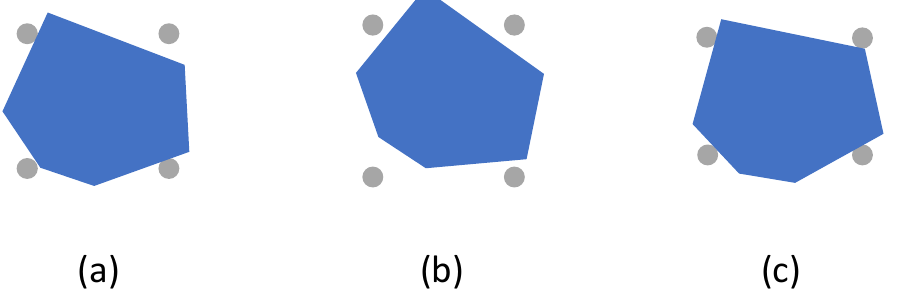
Figure 5. Example of rewards from the GQS function for different cases. ( a ) Some of the pins are on the surface of the object. Reward: − 0.017. ( b ) None of the pins are on the surface of the object. Reward: − 0.048. ( c ) All of the pins are on the surface of the object, but form closure is not achieved. Reward: